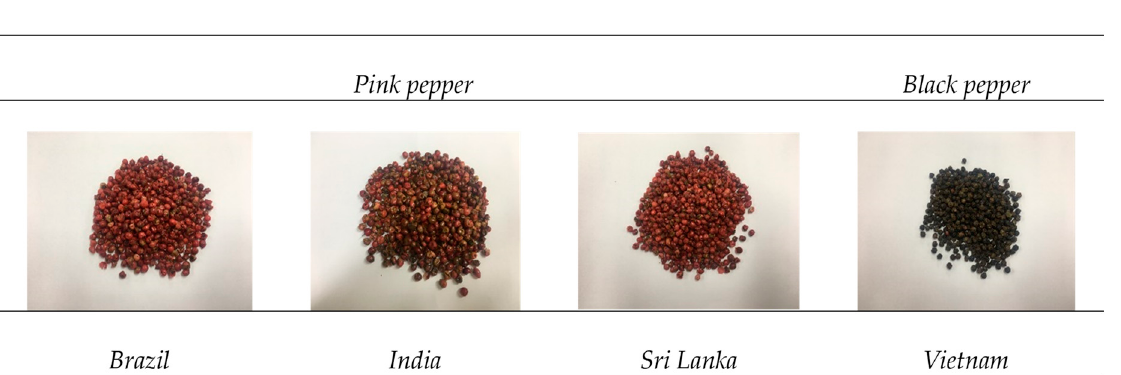
Figure 1. Photographs of dried pink peppers from different countries and black pepper. To compare the general characteristics of pink and black peppers, we analyzed the color and carbohydrate contents of the peppers. Table 1 summarizes the Hunter L, a, b values and fructose and glucose contents of PPB, PPI, and PPS. We determined fructose, glucose, sucrose, and maltose content in the pink and black peppers (S1) using HPLC as- say [16]. While fructose and glucose were not detected in BPV, the pink peppers showed relatively high levels of both monosaccharides. PPS and PPB had the highest fructose con- tent (11,829.82 ± 23.73 mg/100 g) and glucose content (9816.07 ± 36.51 mg/100 g). In the HPLC chromatogram of sugar analysis, we detected two peaks that were consistent with the fructose and glucose standards (Figure S1). Feriani et al. identified fucose (10.90% ± 0.024%) in S. molle fruits from Tunisia, and interestingly, glucose was not detected [15]. On the HPLC chromatogram obtained for pink pepper, we confirmed two peaks that were consistent with the standard peaks of fructose and glucose, but no peaks corresponding to fucose were detected (Figure S1). Therefore, we ruled out the hypothesis that fucose would be present in considerable amount in commercial S. molle . Further, Solis et al. re- ported that fresh and residue seeds of S. molle contained 16% glucose; however, they did not confirm fructose and fucose [22]. In our method, we used 70% EtOH for sample ex- traction, while Feriani et al. used hot water extraction for S. molle fruits from Tunisia. Therefore, these differences in monosaccharide contents seem to be due to the differences in the origin of the peppers, cultivation environment, and the extraction method. Table 1. Color and sugar composition of pink and black peppers. Region N.D. (1) Values are the average of experiments ( n = 5) and represented as mean ± standard deviation; different letters (a–d) in a column indicate values that are significantly different at p < 0.05. 3.2. Total Flavonoid Contents and Total Phenolic Contents Several studies have characterized the chemical and physiological functions of the essential oil [13,14], carbohydrates [15], and fragrance ingredients [12] of S. molle . The es- sential oil and fragrance ingredients are useful for food seasoning. To obtain essential oil and carbohydrates from the pink peppers, the researchers used water as an extraction solvent [12]. Because there are few studies on the application of S. molle fruits as nutraceu- ticals, we analyzed the phenolic and flavonoid content and antioxidant capacity of S. molle and evaluated its potential as a nutraceutical ingredient and antioxidant.